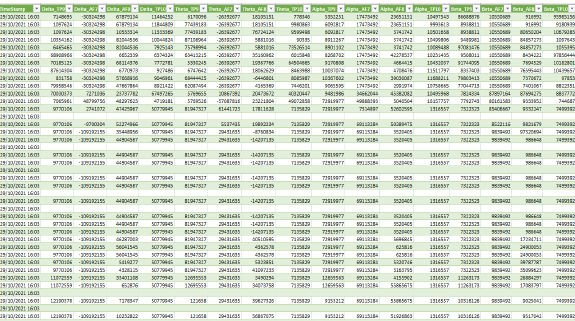
Figure 9. EEG data acquired using Muse2.